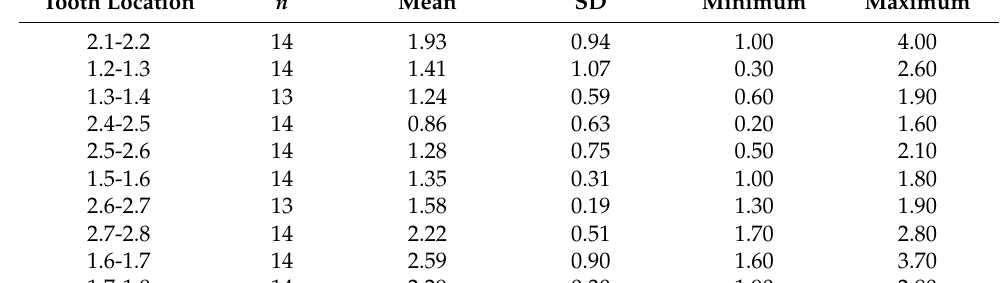
Table 3. Descriptive deviation values at coronal entry-point (mm) of the orthodontic micro-screws placed in the selected tooth positioning.